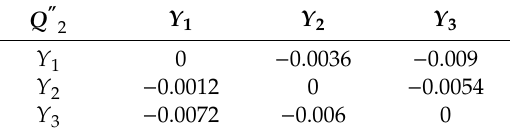
Table 31. The regret matrix Q (cid:48)(cid:48) 2 .